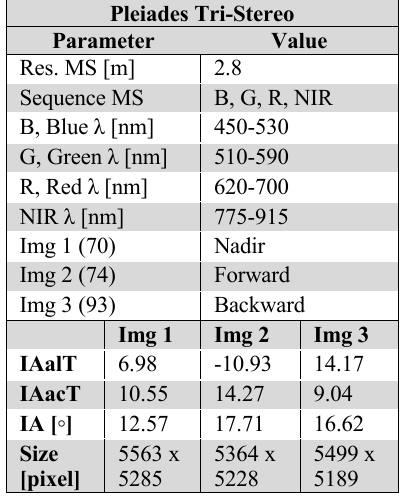
Table 1 . Pleiades VHR Satellite imagery, Airbus. With the incidence angle along track (IAalT), incidence angle across track (IAacT), incidence angle. Dataset.